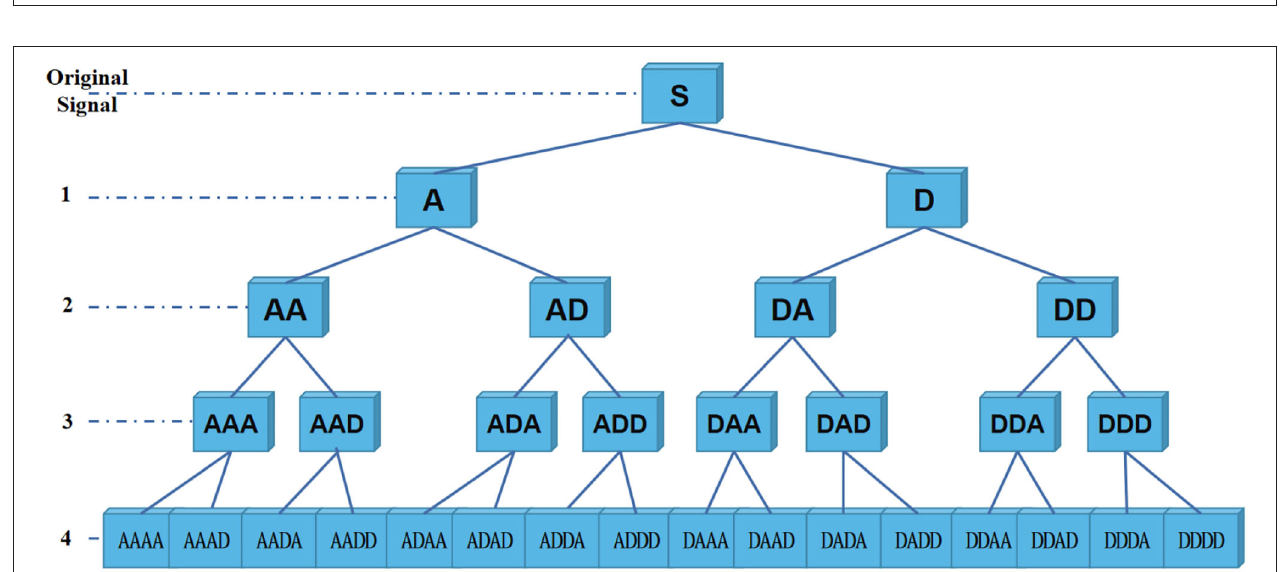
FIGURE 3 | EEG signals are divided into several sub-bands by wavelet packet decomposition.